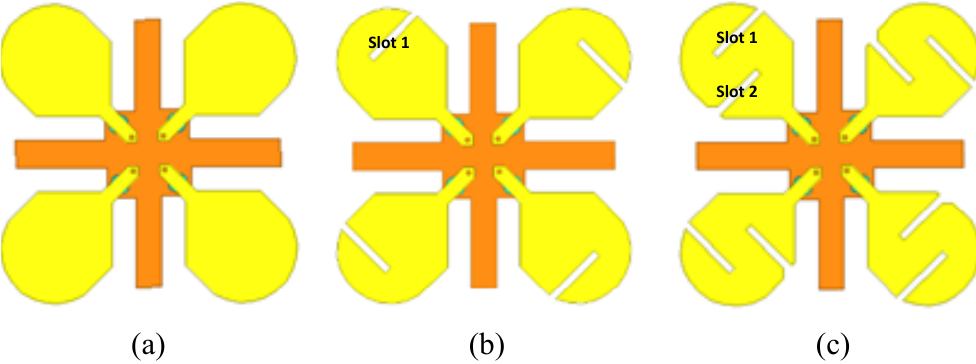
Figure 2. Development steps to achieve dual-band MIMO antenna ( a ) basic elements without slot, ( b ) elements with slot 1, ( c ) elements with slots 1 and 2.